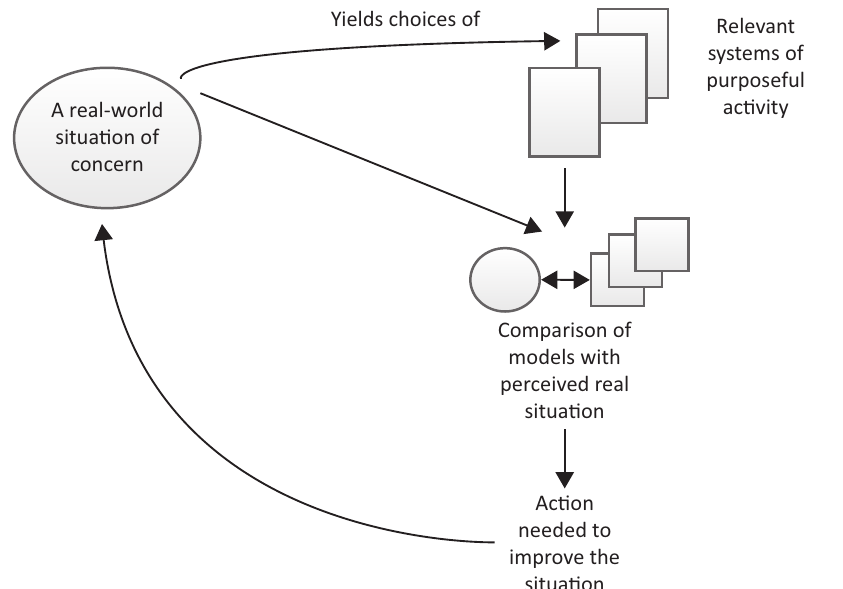
Figure 1. A simplified depiction of SSM. Source: Adapted from Checkland and Scholes